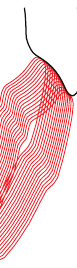
Figure 4: Envelope of the incisors when motion is constrained by the contact between the incisal pin and the ideal incisal table ( MODE B-curved, ideal ). The original teeth shape is accurately rebuilt. Figure 5: Simplified case: a compliant incisal table approximates the ideal shape by changing the uniform curvature of a flexible section “A”, while section “B” is rigid and